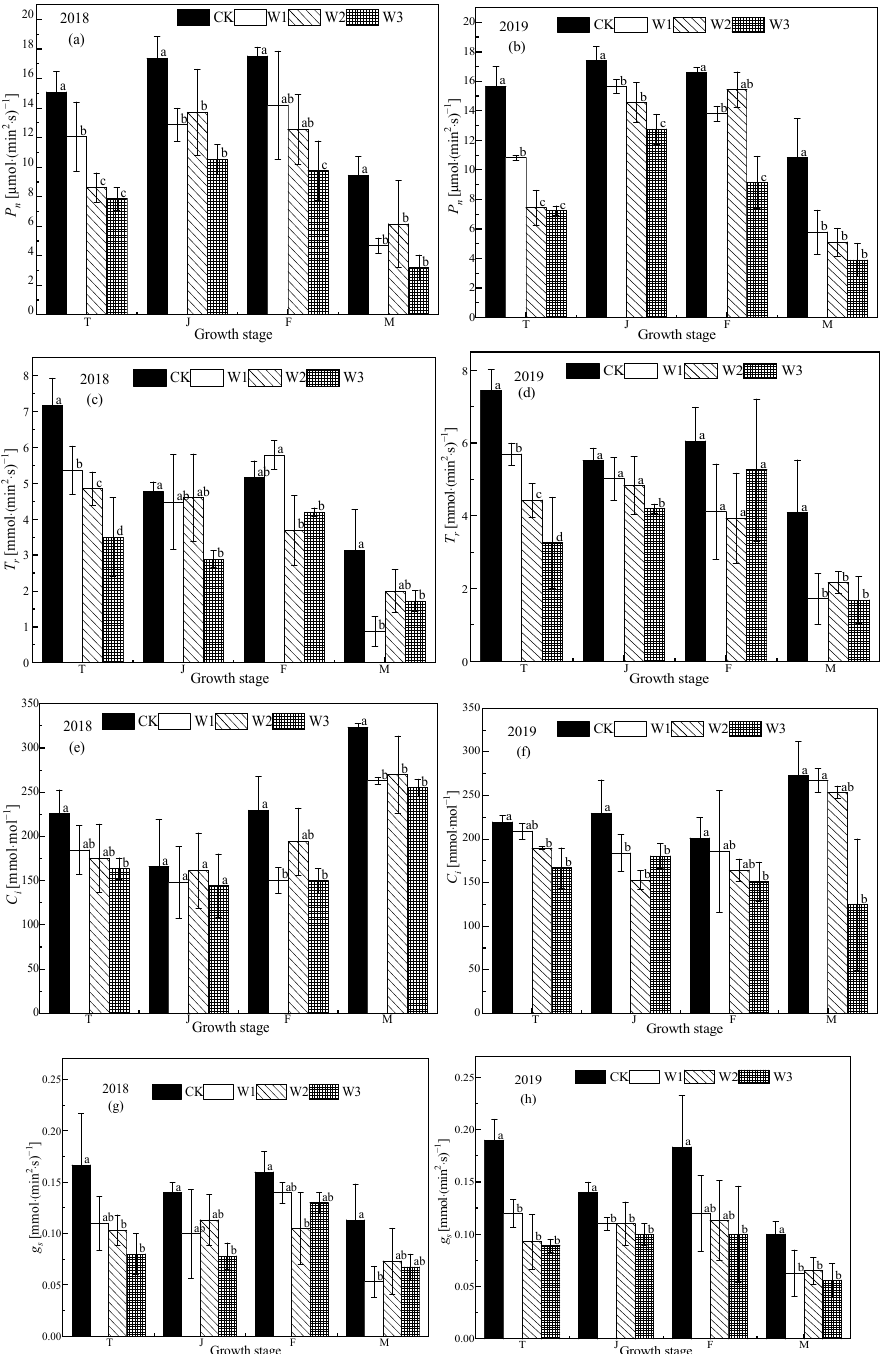
Figure 3. Photosynthetic characteristics of rice under di ff erent water treatment conditions. The ( a ), ( c ), ( e ), and ( g ) represent the P n , T r , C i , and g s respectively in 2018. ( b ), ( d ), ( f ), and ( h ) represent the P n , T r , C i , and g s , respectively, in 2019. T, J, F, and M represent the tillering, jointing, grouting, and mature stages, respectively. CK: flooding treatment, W1: Irrigation limit 0.85–1.00 θ s, W2: Irrigation limit 0.75–1.00 θ s, and W3: Irrigation limit 0.65–1.00 θ s. The data are the mean ± the standard error. Different letters indicate significant differences between treatments ( p < 0.05). Table 3. Correlation matrix between the chlorophyll index and photosynthetic parameters of drip irrigation rice where * indicates significance at p < 0.05 and ** indicates significance at p < 0.01, sample size (N = 24). The maize transpiration rate ( T r ), photosynthetic rate ( P n ), stomatal conductance ( g s ), intercellular CO 2 concentration ( C i ), chlorophyll content (Chl (a + b)).